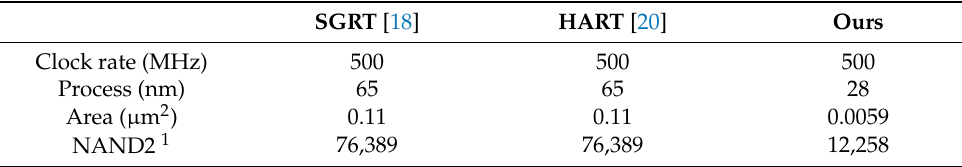
Table 3. Comparison of different reciprocal unit.